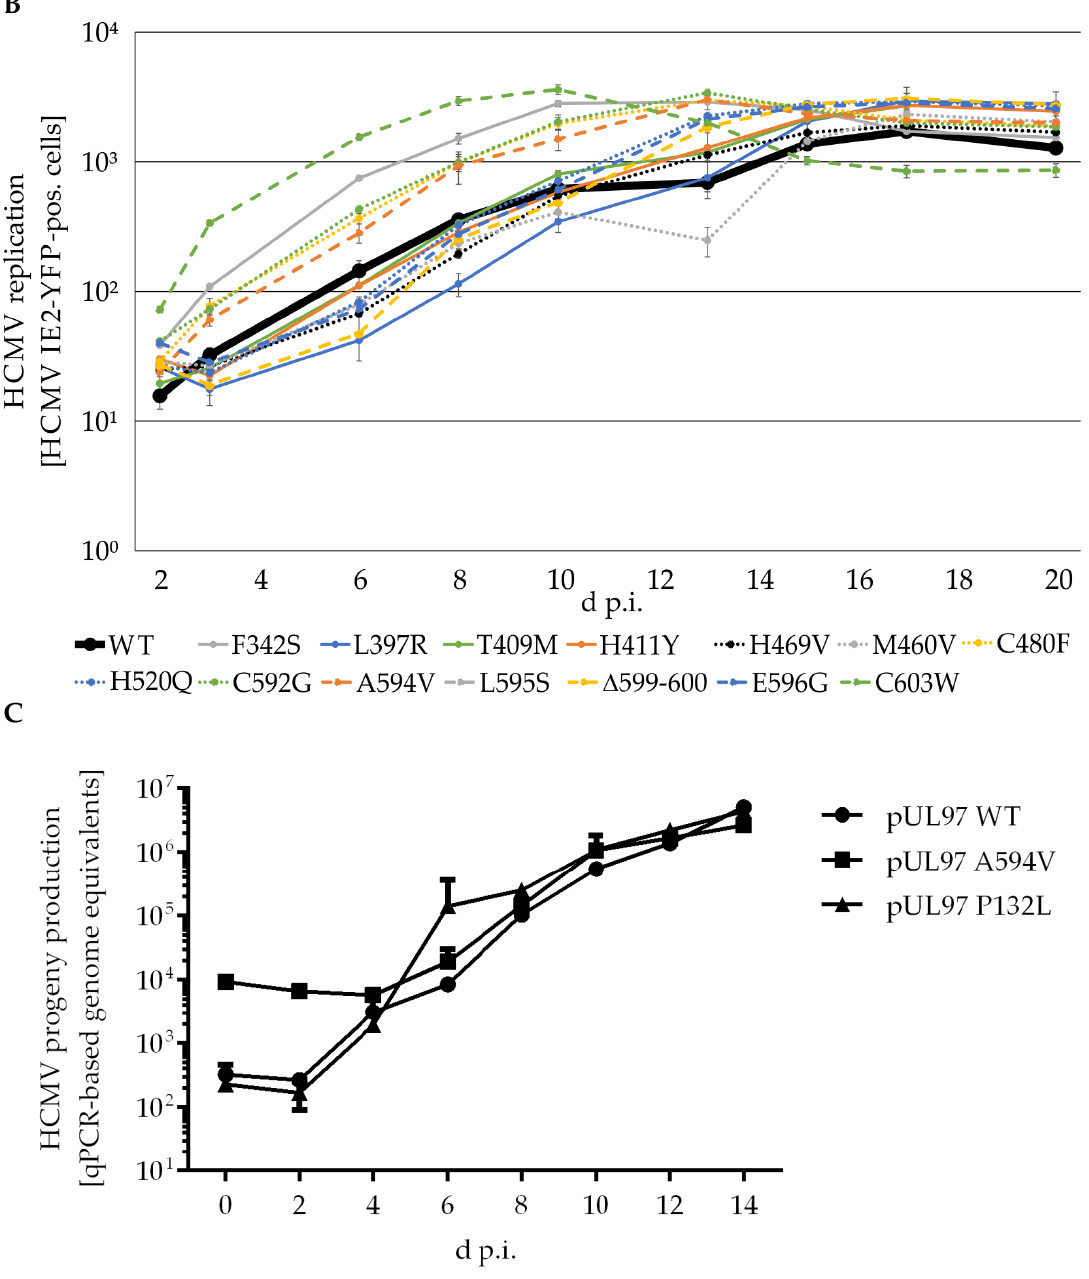
Figure 2. Viral replication kinetics determined by HCMV-specific qPCR and quantitation of IE2- YFP positive cells. ( A ) 225,000 HFFs in 12-well plates were infected with parental HCMV strain TB40 WT or ORF-UL97 point mutants at a viral dose of 1 × 10 5 genome copies. Viral supernatants were harvested at indicated time points and viral genome equivalents were determined by qPCR. Each value represents the mean ± SD of two independent biological replicates, each measured twice. ( B ) Alternatively, 13,500 HFFs in 96-well plates were infected at an MOI of 0.01 and the number of HCMV-infected cells was measured by detection of YFP signal-positive cells at indicated time points, using ImageXpress Pico. Values are given as mean value ± SD of three independently in- fected wells. ( C ) HFFs were infected with parental HCMV strain Merlin WT or ORF-UL97 point mutations (A594V, conferring GCV resistance; P132L, not conferring drug resistance) at an MOI of 0.001. Viral genome copies in the supernatant were determined using qPCR. Each value is given as the mean ± SD of three independent biological replicates.